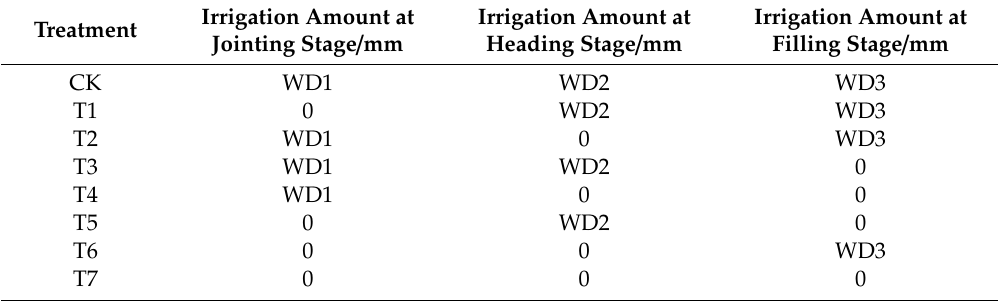
Table 3. Simulation of potential drought at di ff erent growth stages. Irrigation Amount at Treatment Jointing Stage / mm